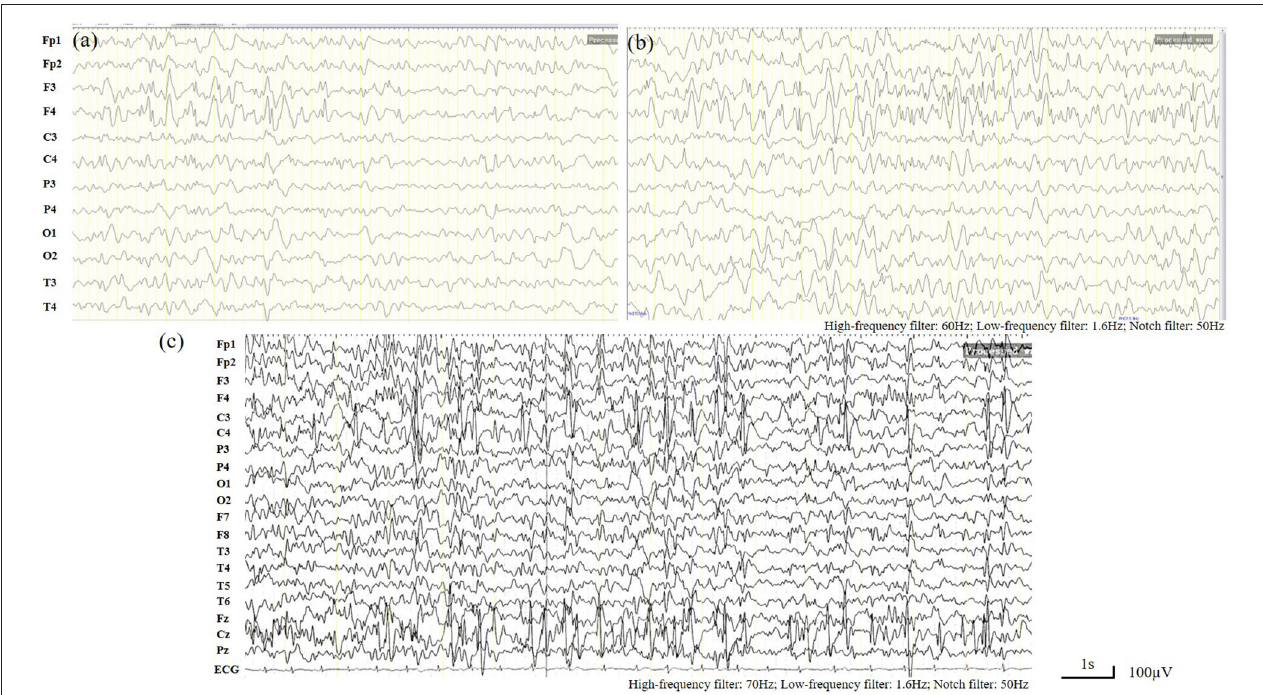
FIGURE 1 | Electroencephalogram (EEG). (a,b) Routine sleep EEG tracing at the age of 11 months. Continuous spike-waves from the bilateral frontal regions, forming more than 80% of the sleep recording, suggesting an electrical status epilepticus during slow-wave sleep (ESES) like EEG finding. (c) Overnight sleep EEG tracing at the age of 2 years and 10 months. Almost continuous spike- waves predominantly over both frontal regions were occupying more than 80% of the sleep recording, which is consistent with ESES.